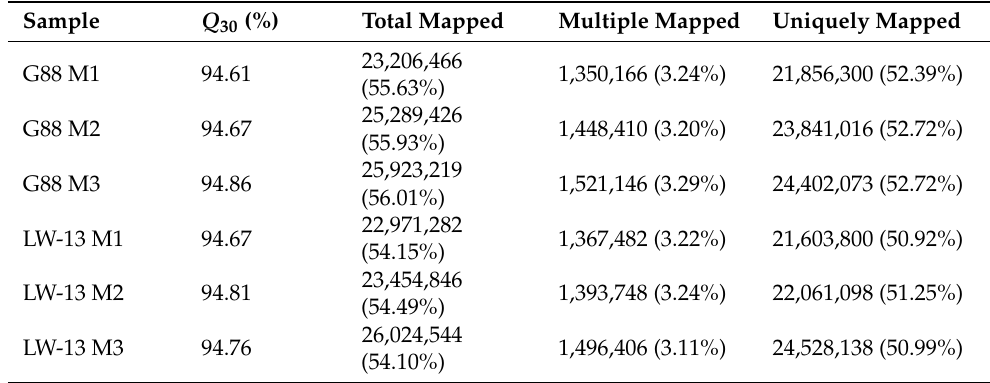
Table 1. Summary of transcriptome-sequencing results generated from G88 and LW-13.